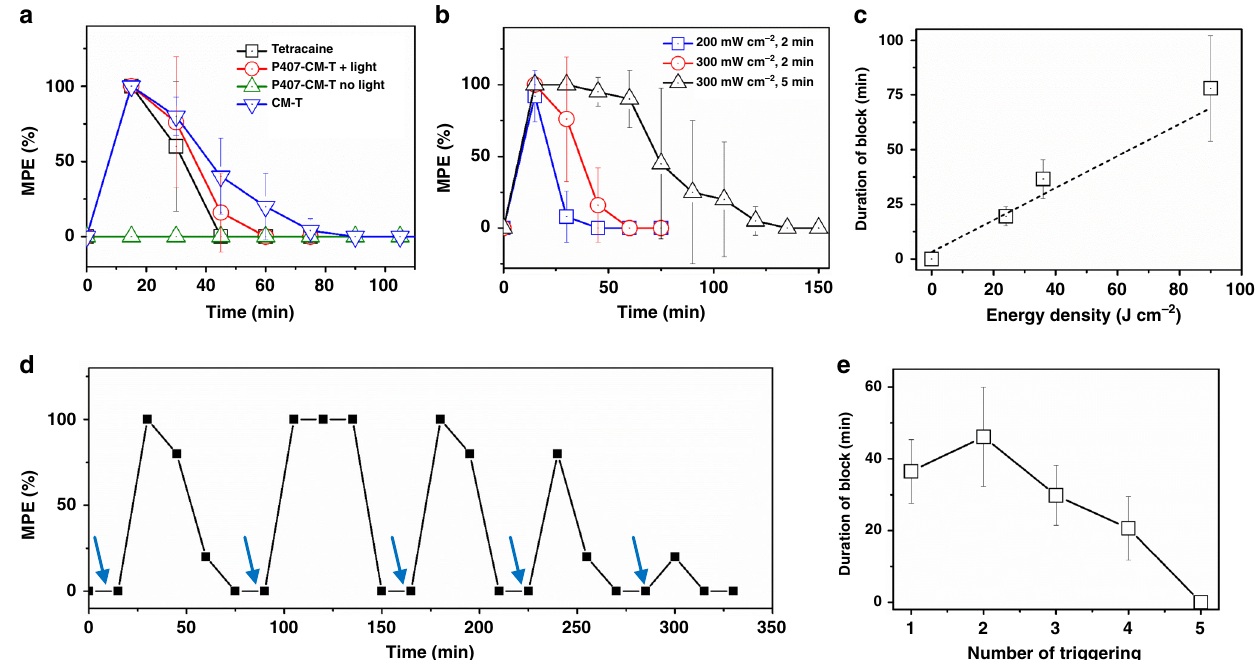
Fig. 5 Photo-triggered local anesthesia in the rat footpad. a Time courses of nerve block after injection of tetracaine (black line, n = 6), CM-T (tetracaine bound to coumarin without P407, blue line, n = 5) and P407-CM-T with (red line, n = 4) or without (olive line, n = 4) 2 min irradiation at 300 mW cm − 2 , immediately after injection. b Nerve block after irradiation of P407-CM-T with irradiation at various irradiances and durations (blue line: 200 mW cm − 2 , 2 min; red line: 300 mW cm − 2 , 2 min; black line: 300 mW cm − 2 , 5 min; n = 4). (The red plot is also in a ) c Effect of energy density on the duration of the triggered nerve block ( n = 4). d Representative time course of nerve block with multiple light triggering events (blue arrows represent LED triggering for 2 min at 300 mW cm − 2 ). e The mean duration of block after each triggering event in d ( n = 4). Data are means± SD. Source data are provided as a Source Data fi